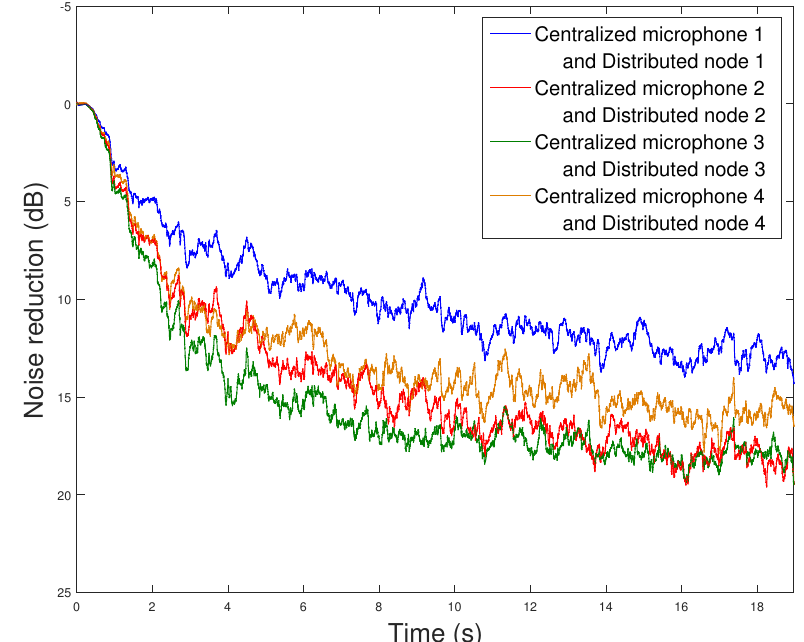
Figure 8. Noise reduction obtained by both the four-node distributed system and the centralized system with a 1:4:4